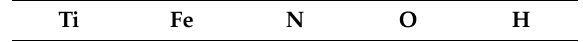
Table 1. Chemical composition (wt. %) of commercial-purity titanium (CP-Ti).